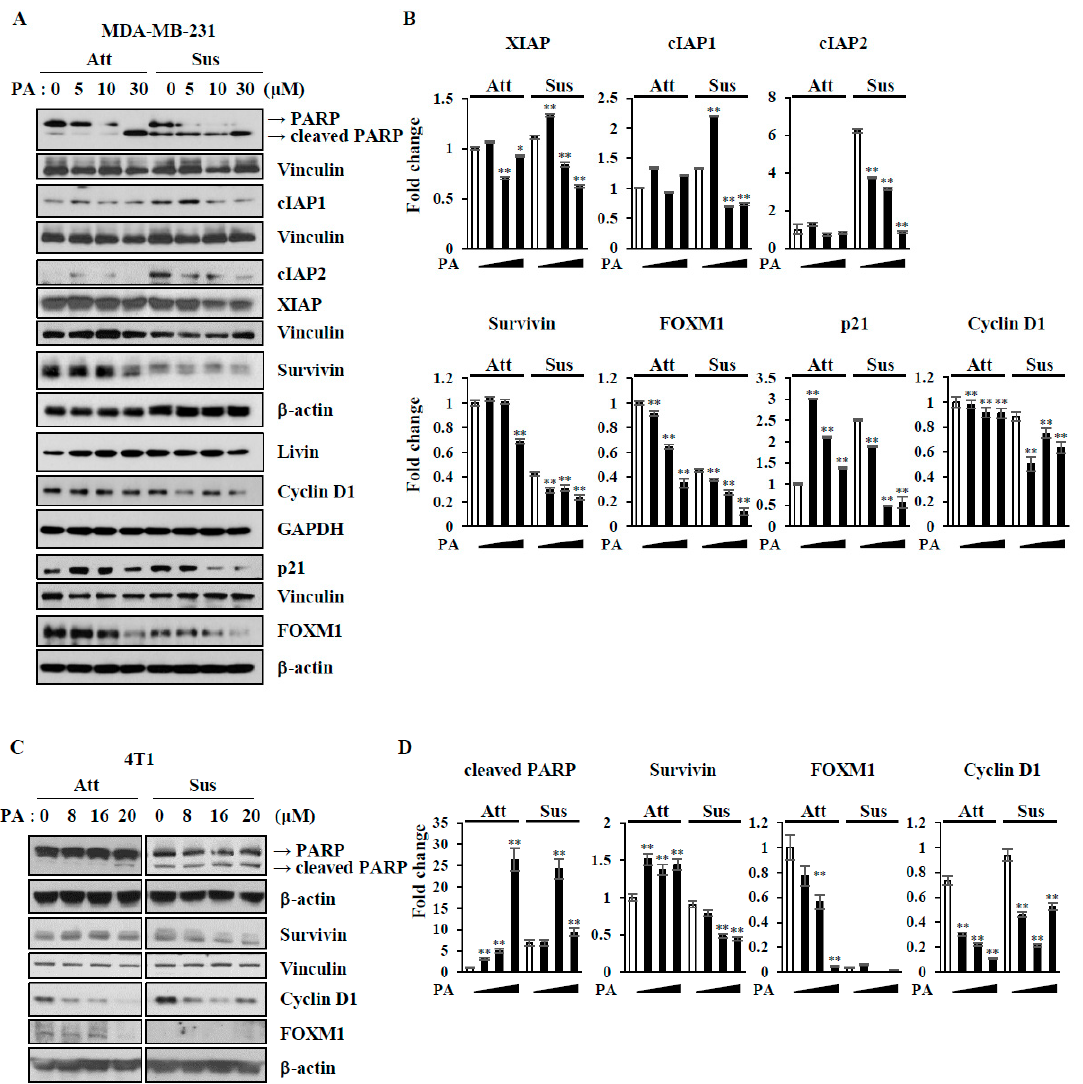
Figure 3. E ff ects of PA on the expression levels of proteins for cell survival and apoptosis. ( A , C ) MDA-MB-231 cells ( A ) and 4T1 cells ( C ) were treated with the indicated concentrations (0–30 µ M) of PA for 24 h, and cell lysates were subjected to immunoblotting analysis using the indicated antibodies. ( B , D ) The levels of proteins were quantified by densitometry and normalized to reference proteins (actin or vinculin or GAPDH). Error bars represent standard deviations of the mean of three measurements (* p < 0.05, ** p < 0.01). Similar results were observed in three independent experiments.